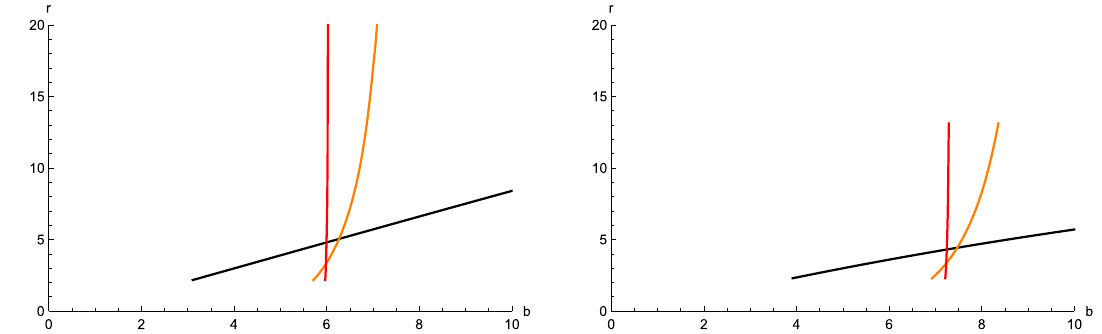
Fig. 4 The first three transfer functions r m ( b ) for the thin disk in the quintessence black hole with w = − 0 . 5 (left panel) and w = − 0 . 7 (right panel). The black lines, orange lines and red lines stand for the radial coordinate of the first, second, and third intersections with a face-on thin disk outside the